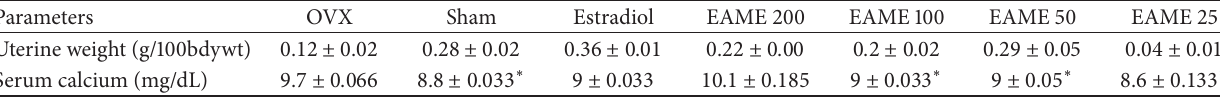
Table 1: Effect of EAME on uterine weight and serum calcium of ovariectomised